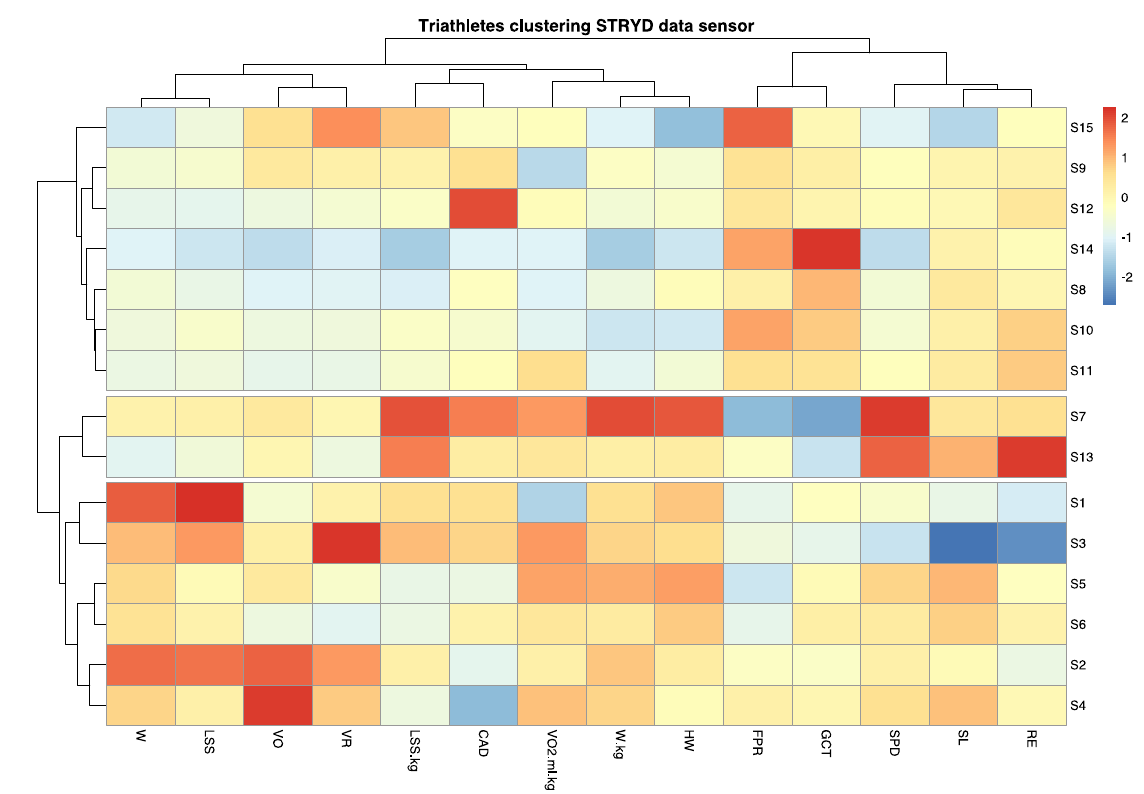
Figure 4. Heat map of the clustering of athletes. The participants distributed into cluster 1 (S1, S2, S3, S4, S5, and S6), cluster 2 (S7 and S13), and cluster 3 (S8, S9, S10, S11, S12, S14, and S15).